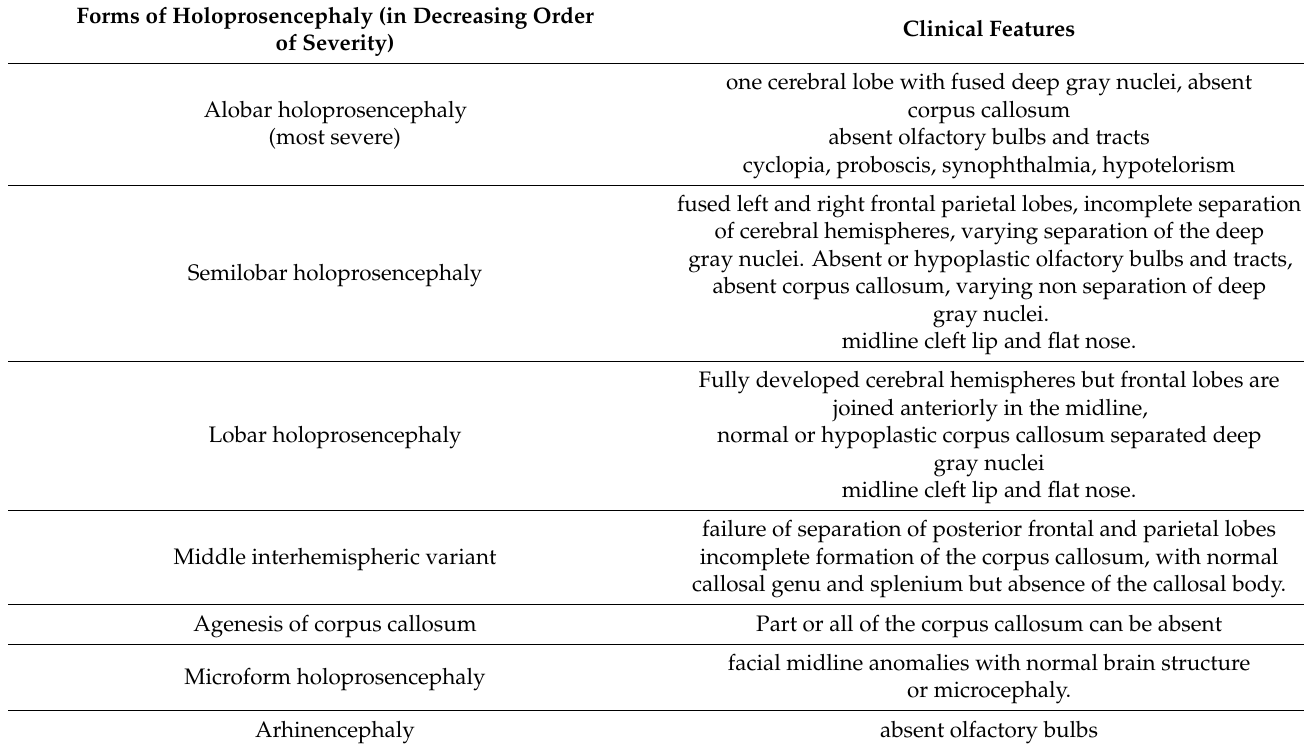
Table 2. Clinical Forms of